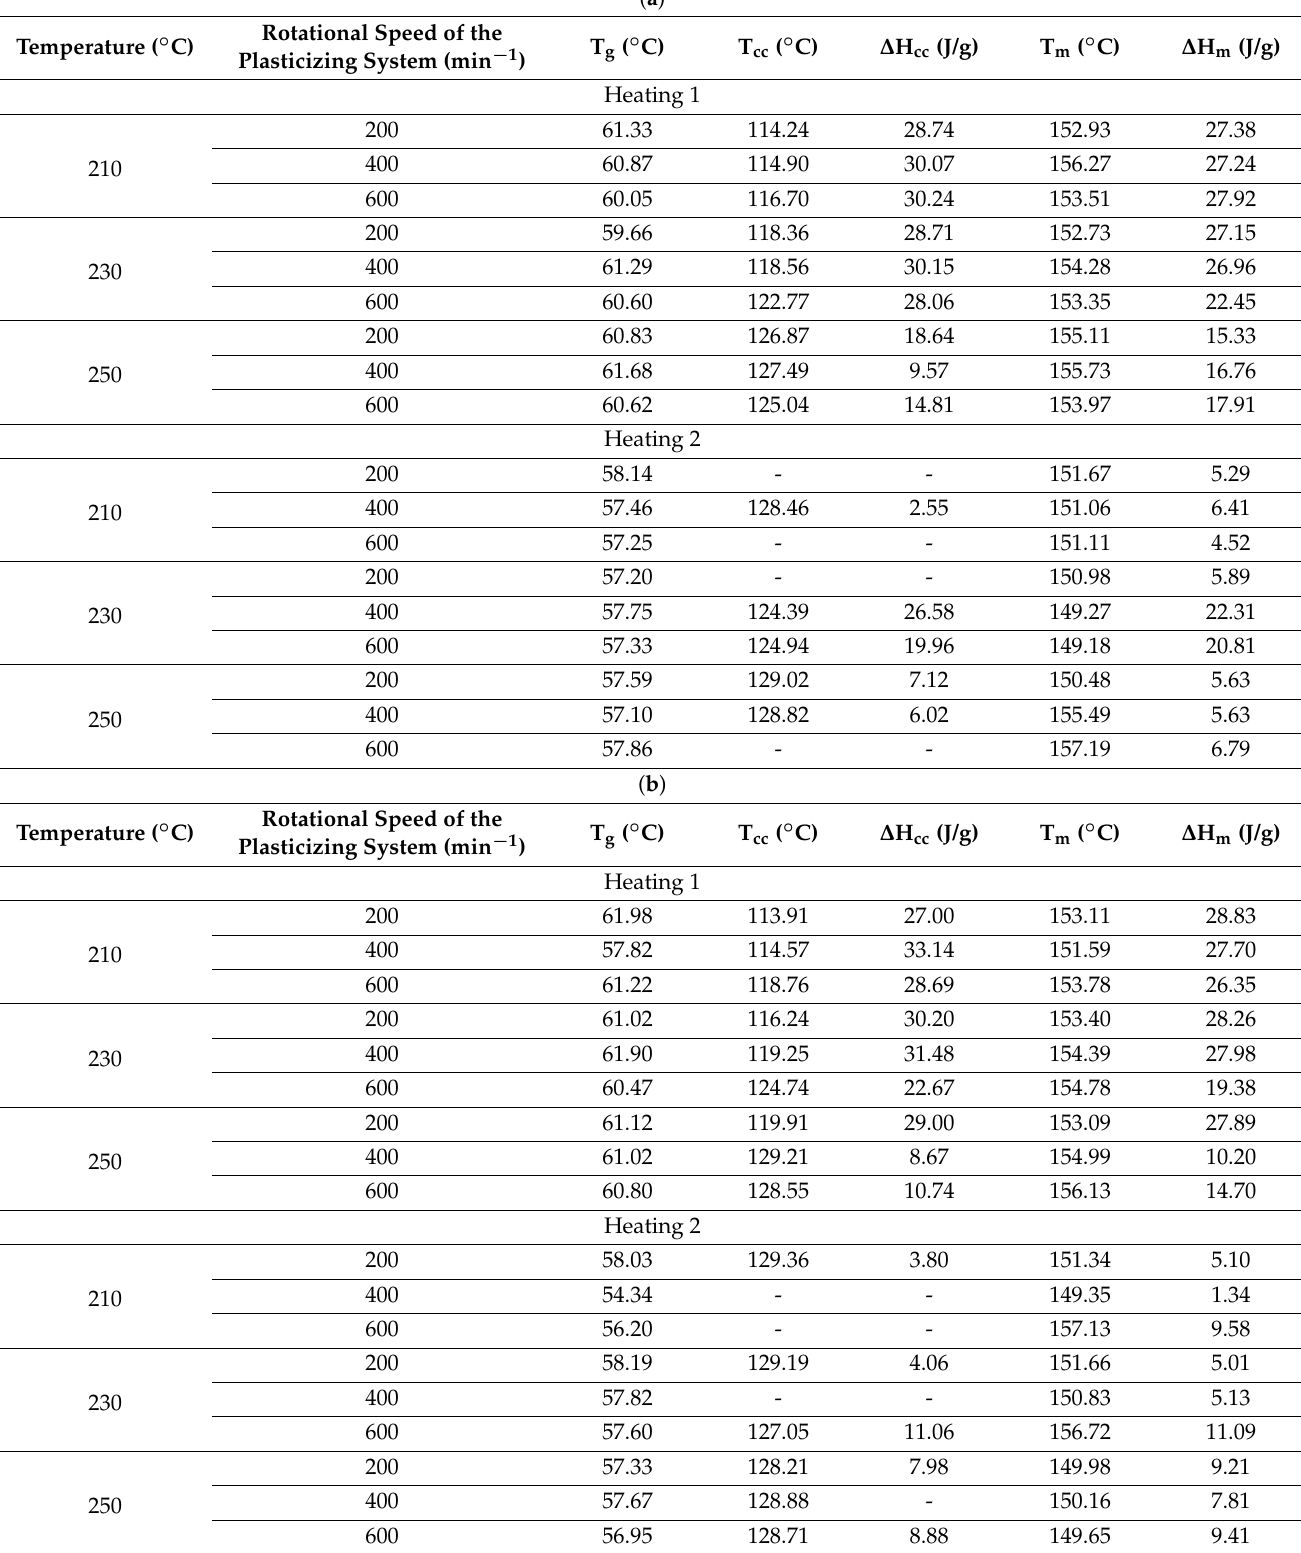
Table 2. Summary of DSC parameters: ( a ) configuration 1; ( b ) configuration 2. Abbreviations: as in Table